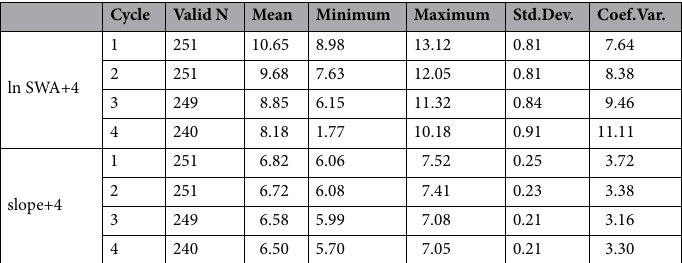
Cycle Valid N Mean Minimum Maximum Std.Dev.